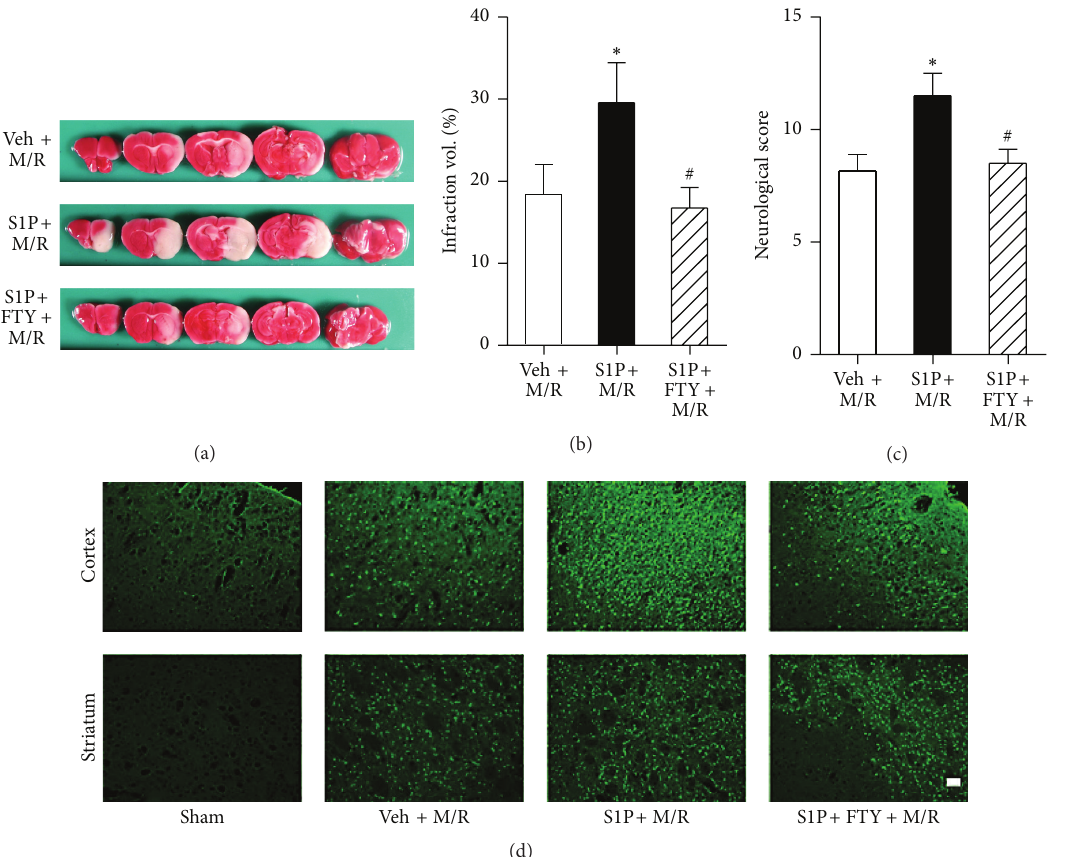
Figure 5: Activation of S1P signaling induces augmented brain damage following M/R injury. S1P or vehicle (veh) was microinjected into the corpus callosum 24h prior to M/R challenge (60min occlusion followed by 22 h reperfusion). FTY720 (FTY) was administered into mice 30 min prior to 60min occlusion. Brain infarction or neuroinflammation was assessed 22 h after reperfusion. (a) Representative TTC-stained brain slices of veh + M/R, S1P + M/R, and S1P + FTY + M/R. Photographs are coronal brain sections stained with TTC showing infarct area (white) and intact area (red). (b) Percentage of infarct volumes calculated from the TTC-stained brain slices. Infarct volume was measured using Image J software and the percentage of infarction was assessed. (c) Neurological score demonstrating neurological functions. ∗ 𝑃 < 0.05 and # 𝑃 < 0.05 , compared with the M/R group (veh + M/R) and S1P + M/R group, respectively (Newman-Keuls test). 𝑛 = 6 ∼ 8 per group. (d) Representative microphotographs of cortex and striatum regions stained with Fluoro-Jade B. Scale bar, 50 𝜇